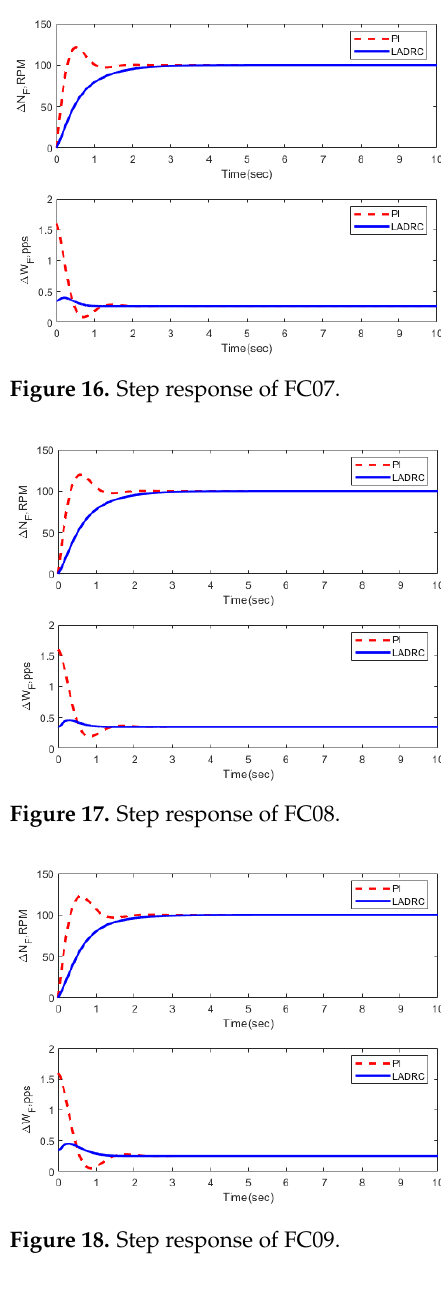
Figure 19. Step response of FC10.